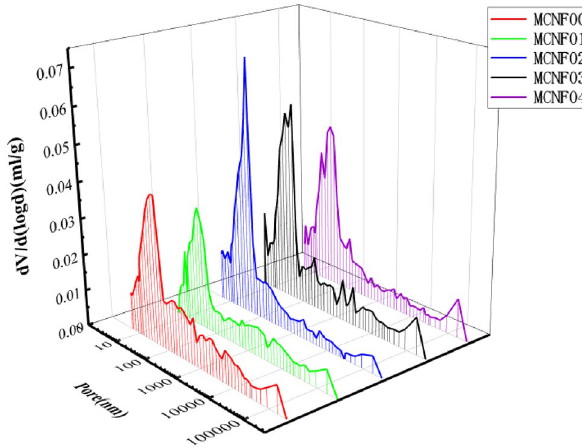
Figure 9. Effects of MCNF on the pore size distribution.